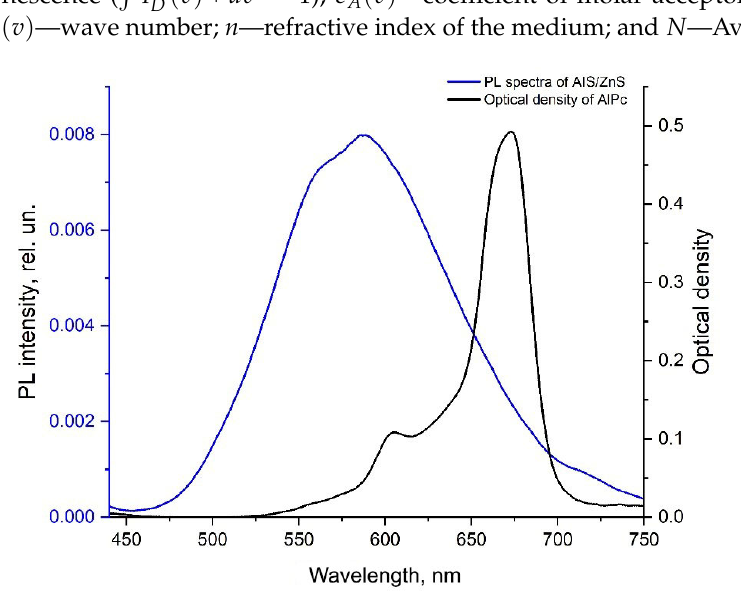
Figure 9. Overlapping spectra of AIS/ZnS QDs luminescence and PS absorption spectrum marked by green. The donor luminescence spectrum (QDs) was normalized by area.